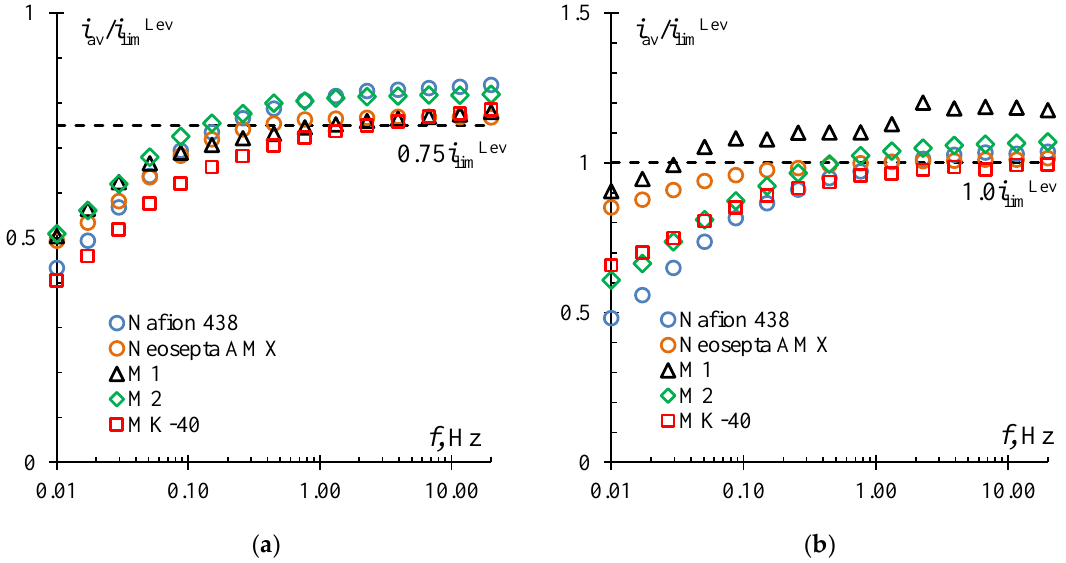
Figure 6. The results of testing the Nafion 438, Neosepta AMX, M1, M2, and MK-40 membranes in the pulsed electric field mode: i = 0.75 i limLev , duty cycle 1/4 ( a ), and 1.0 i limLev , duty cycle 1/4 (excluding results for Neosepta AMX membrane for which they are shown at 1.0 i limLev and α = 2/3) ( b ). The horizontal dashed line denotes the i / i limLev ratio corresponding to a given potential drop U av in the DC mode.